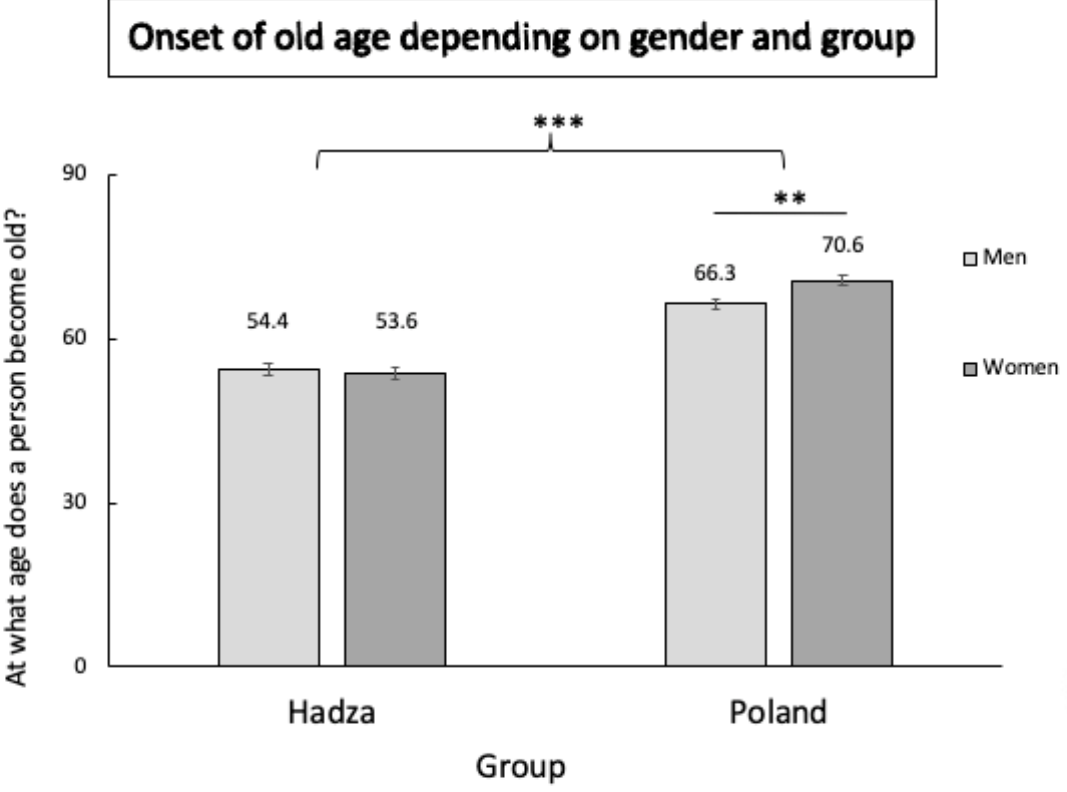
Figure 1. Distribution of perceived onset of old age in Polish (N Women = 66 and N Men = 58) and Hadza (N Women = 47 and N Men = 49) men and women. ** p <.01, *** p <.001